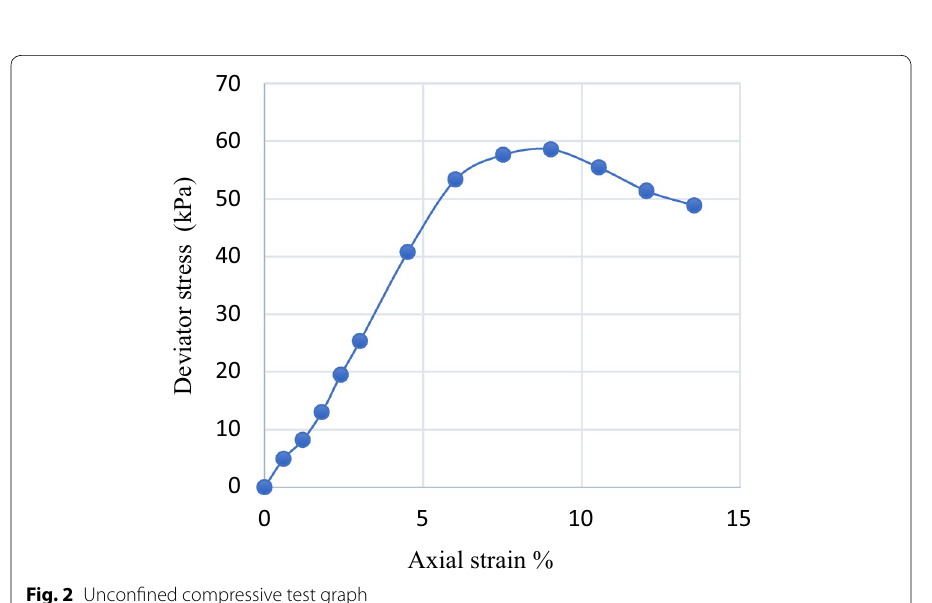
Fig. 2 Unconfined compressive test